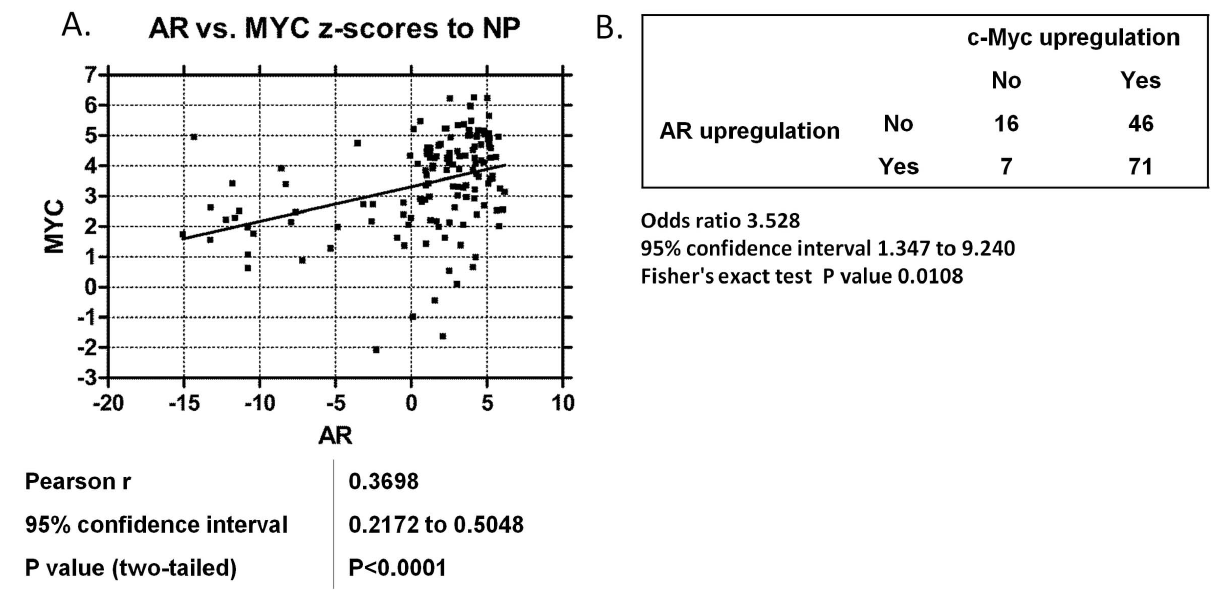
Figure 1. AR and c-Myc levels are positively correlated in CRPC specimens. A) Z-scores (to normal prostate specimens) of AR versus c-Myc mRNA expression across 140 human CRPC metastases. The Pearson correlation coefficient, linear regression, and F test for significantly non-zero slope were performed for each pair of genes. B) Fisher’s exact test and odds ratio on the contingency table analyzing the co-occurrence of tumors with AR or c-Myc z-scores greater than